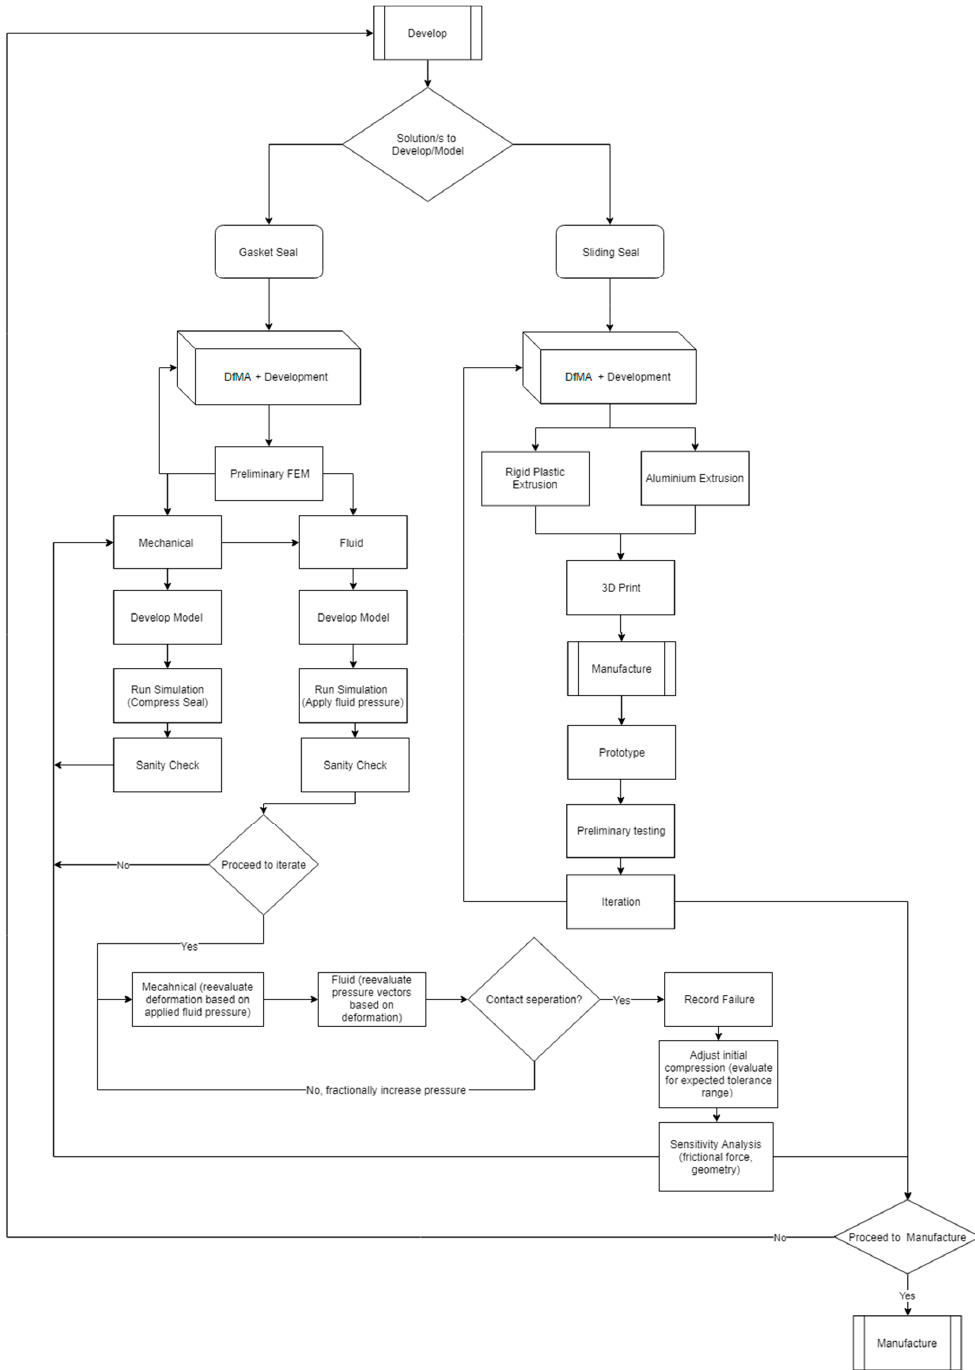
Figure 11. The Development process broken down to its components.